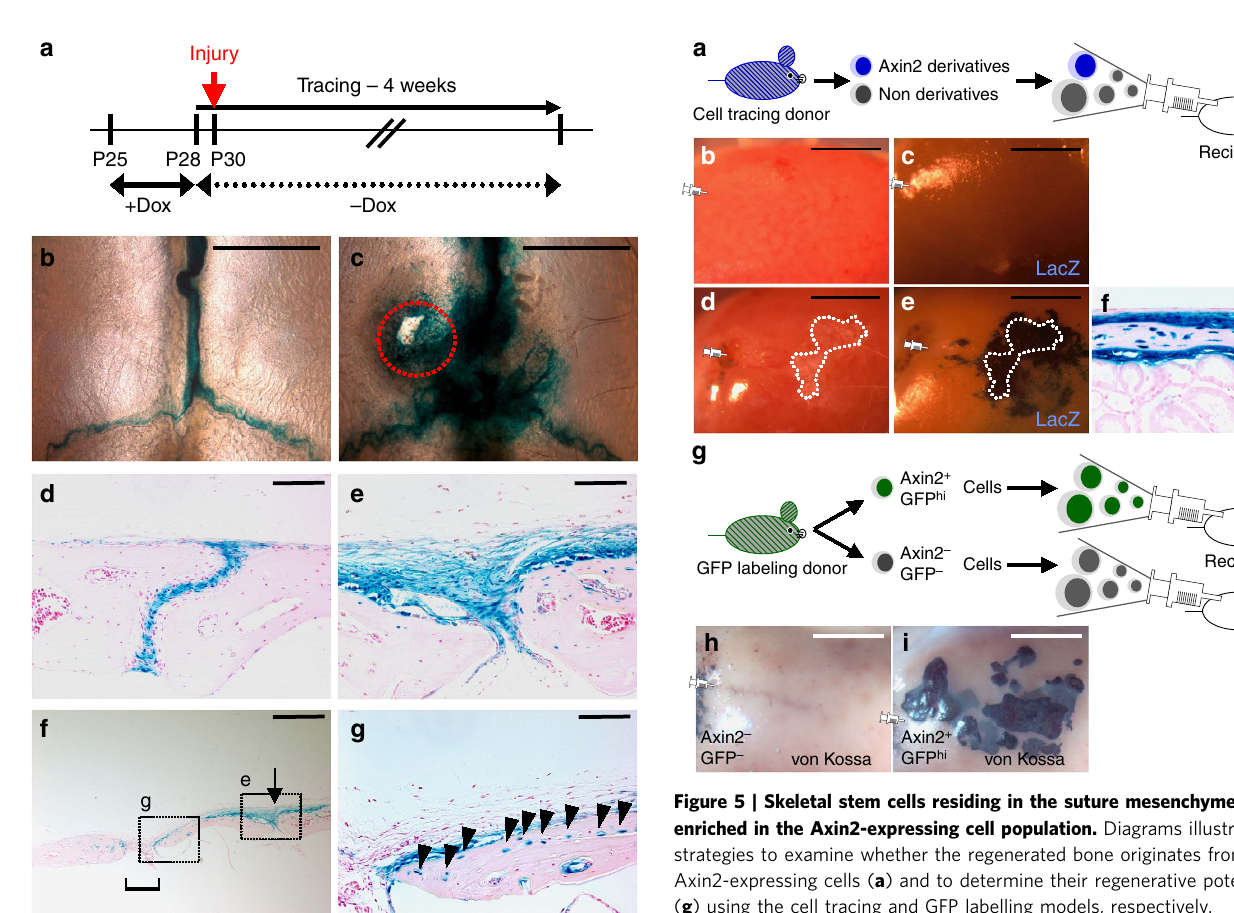
results suggest that markers for bone marrow-derived skeletal stem cells may not be used for identification of SuSCs.